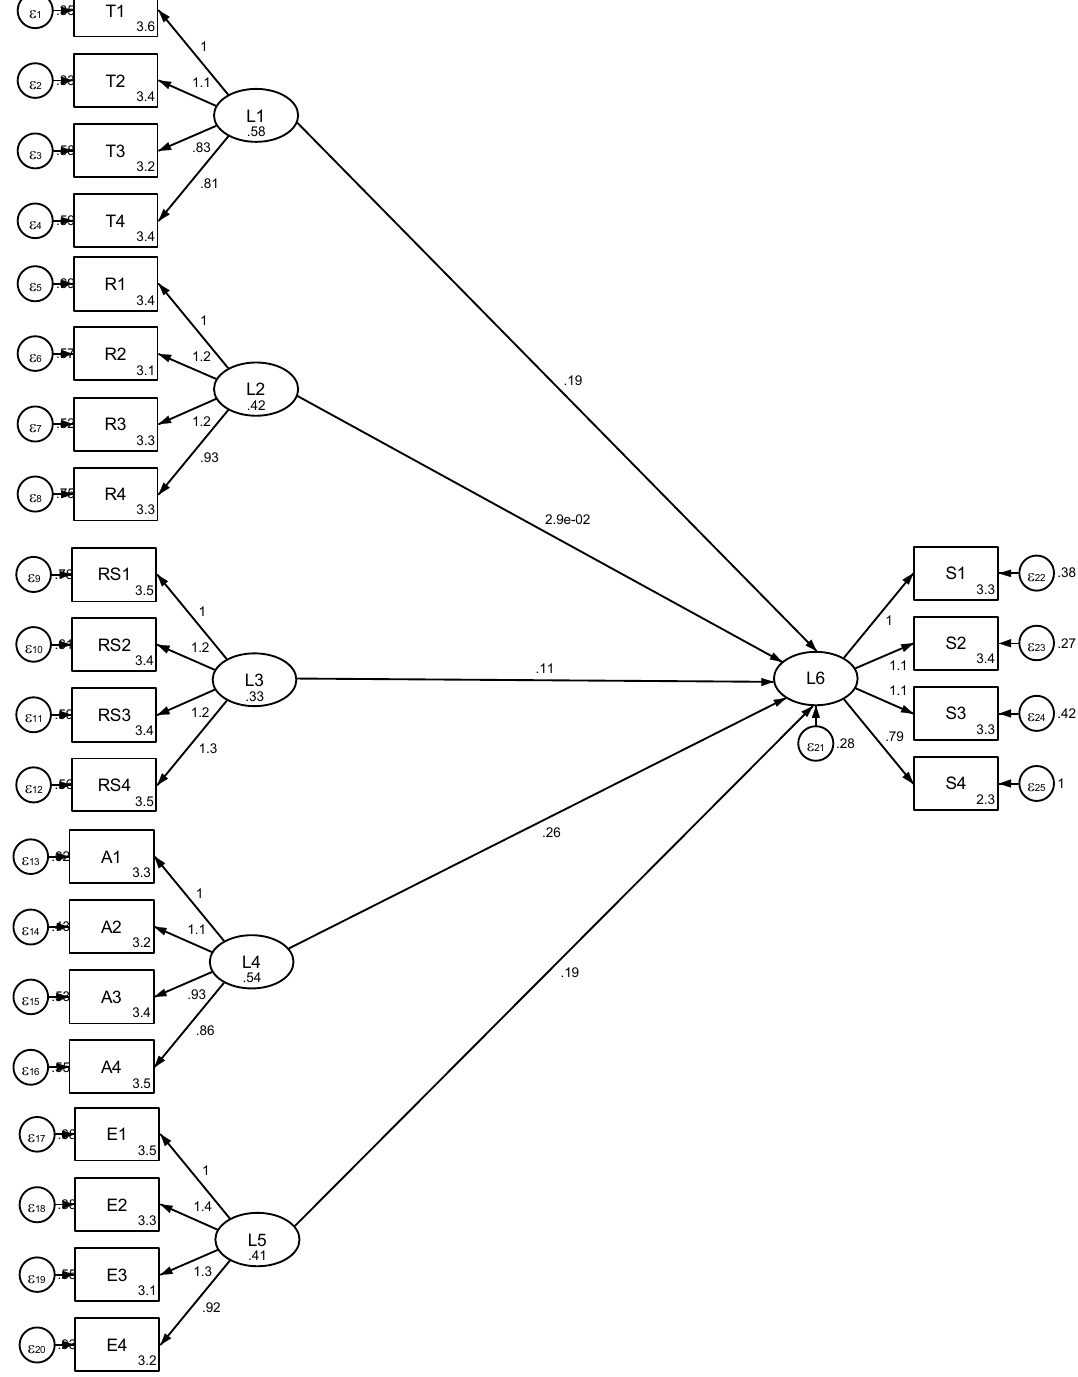
Fig. 1. Structural Equation